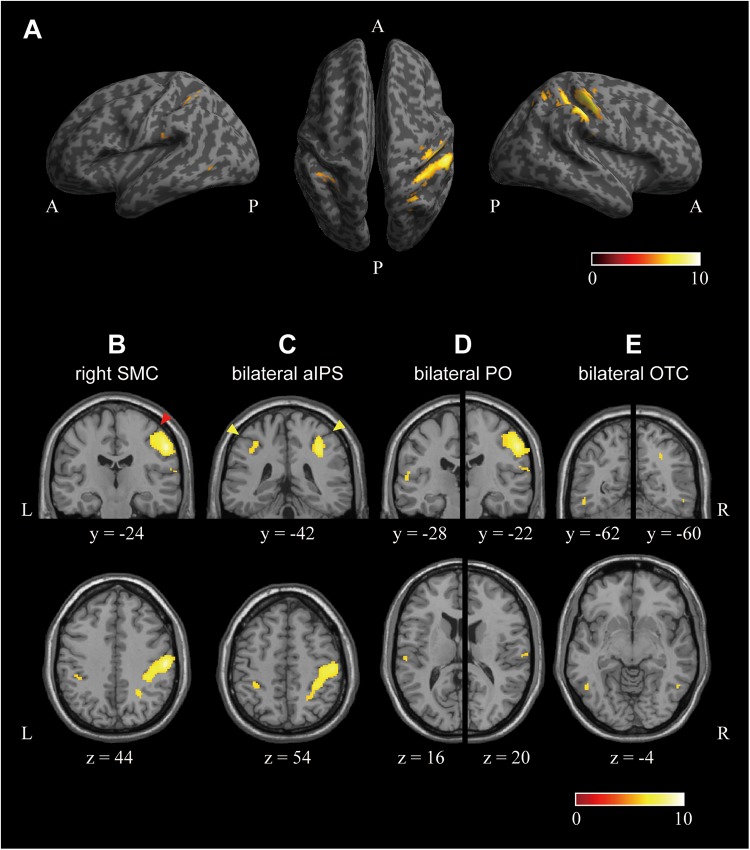
Cortical regions encoding the perceived hardness with visual modulation. Regions encoding the perceived hardness with visual modulation were investigated by conjunction analysis of the three comparisons of (SFTvm vs. MED), (HRDvm vs. MED), and (SFTvm vs. HRDvm). (A) The surface view. Left: lateral view of the left hemisphere, Right: lateral surface of the right hemisphere, Middle: top view of both hemispheres. (B) A cluster observed in the right sensory motor cortex (SMC). The coronal section at the local maxima identified in S1 is shown. (C) Clusters observed in the anterior intraparietal sulcus (aIPS) in both hemispheres. The cluster in the right aIPS was part of the large cluster in the SMC. (D) Clusters obtained in the parietal operculum (PO) of both hemispheres. (E) Clusters in the bilateral occipito-temporal cortex (OTC). The cluster was located in the posterior inferior temporal sulcus. The red and yellow arrow heads in (B,C) indicate the central and intraparietal sulcus, respectively. The peak and extent thresholds were the same as in Figure 5. The color bars indicate the T-value. A, anterior; P, posterior.